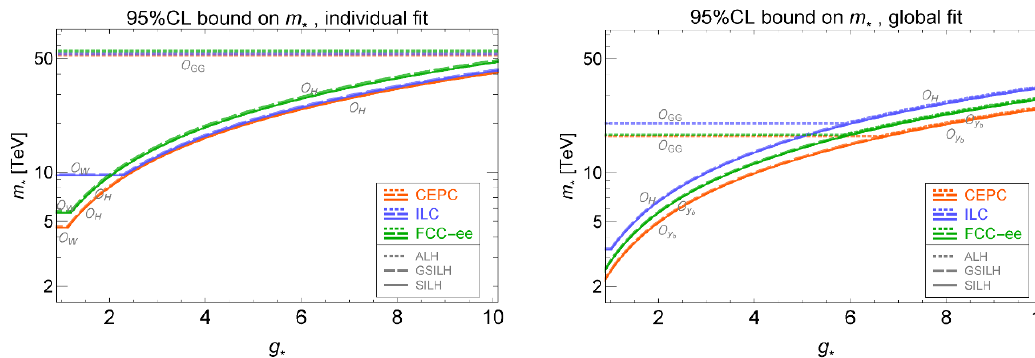
Figure 13 . The 95% C.L. limit on the new physics scale for the three cases of ALH (dotted lines), GSILH (dashed lines) and SILH (solid lines) as a function of g (cid:3) with CEPC (red), ILC (blue) and FCC-ee (green) precision. The left plot is the results obtained using (cid:12)t on individual operators, and the right plot is the results obtained using global (cid:12)t of all 12 operators. The operator that is most sensitive (therefore determines the best reach) is labelled alongside the